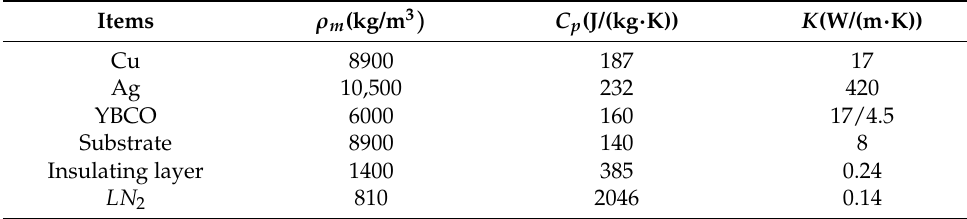
Table 2. The main parameter values of thermal field